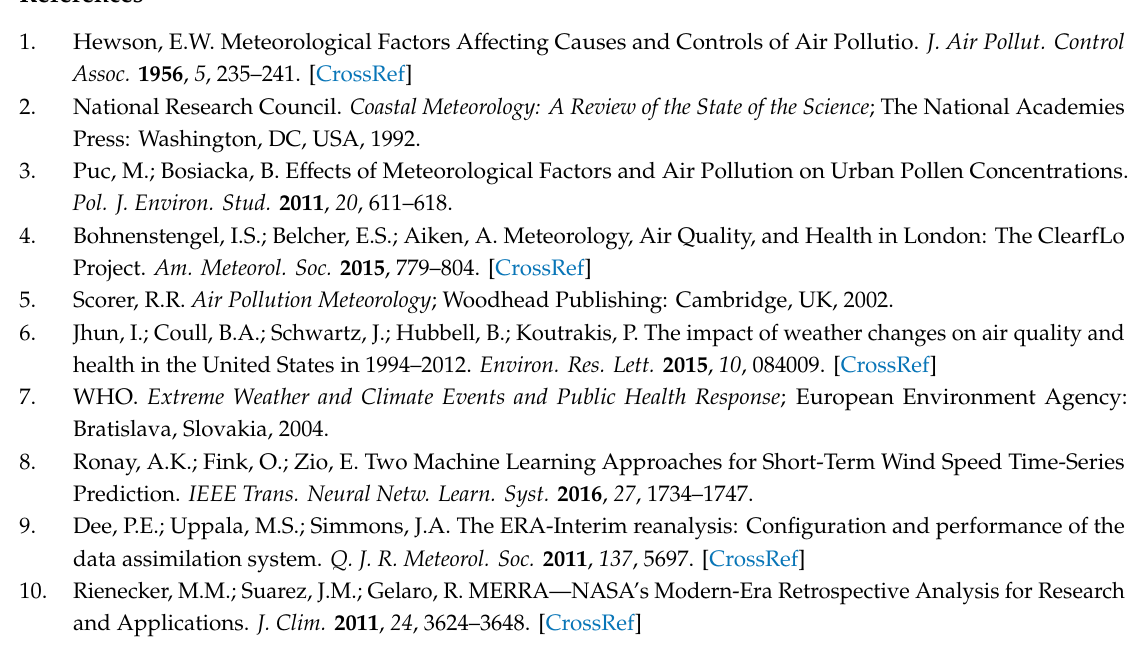
Table S1: Variogram fitting and cross validation for estimation of the residuals of predicted wind speed for four typical seasonal days (b); Figure S1: Histograms for wind speed (a) and its log transformations (b); Figure S2: Boxplots of the observed values and ensemble predictions by GWR for wind speed; Figure S3: Plots of variogram fitting; Figure S4: Plots of the original residual from ensemble predicted wind speed vs. estimated residuals using fitted variogram based universal kriging (UK) for four typical seasonal days; Figure S5: Predictions by individual models (a for autoencoder-based deep network, b for XGBoost and c for random forest) and their ensemble predictions by GWR for wind speed of 1 July 2015; Figure S6: Spatially varying intercept (a) and coe ffi cients (b, c and d) for the predictions of thee individual learners for wind speed; Figure S7: Spatially varying variance for the ensemble predictions by GWR for wind speed; Figure S8: Plots of averages of matched finely resolved wind speed (a and c) and their residuals (b and d) vs. the coarsely resolved wind speed (reanalysis data) for 1 January 2015 (a and b) and 1 July 2015 (c and